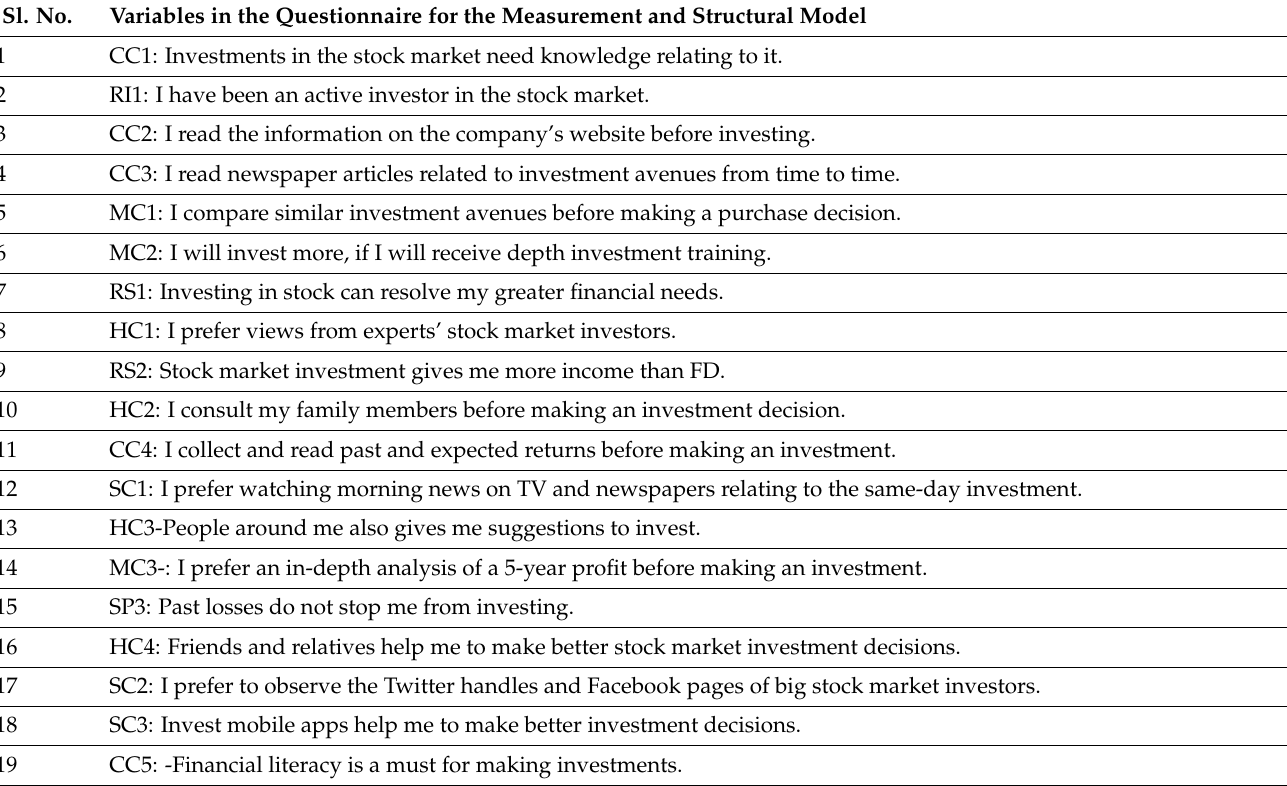
Table 1. Variables, taken in questionnaire for data collection and their codes for analysis in the measurement and structural